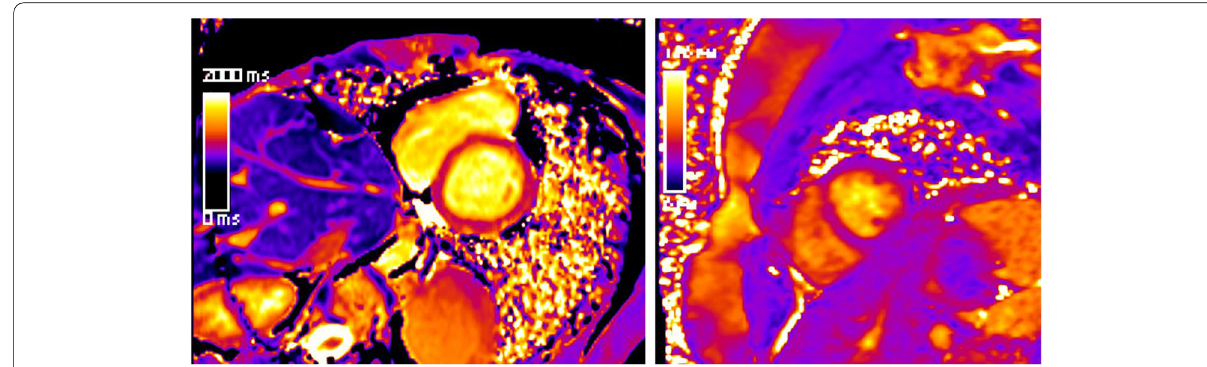
Fig. 7 (Mapping technologies): qualitative (based on color maps) and quantitative (based on signal intensities) assessment is possible; in comparison to values of healthy cohorts, increased T2 values indicate myocardial edema and increased T1 values indicate fibrosis; here, healthy myocardium is depicted for SAX-T2- (left) and pre-contrast (“native”) T1 mapping (right) in midventricular